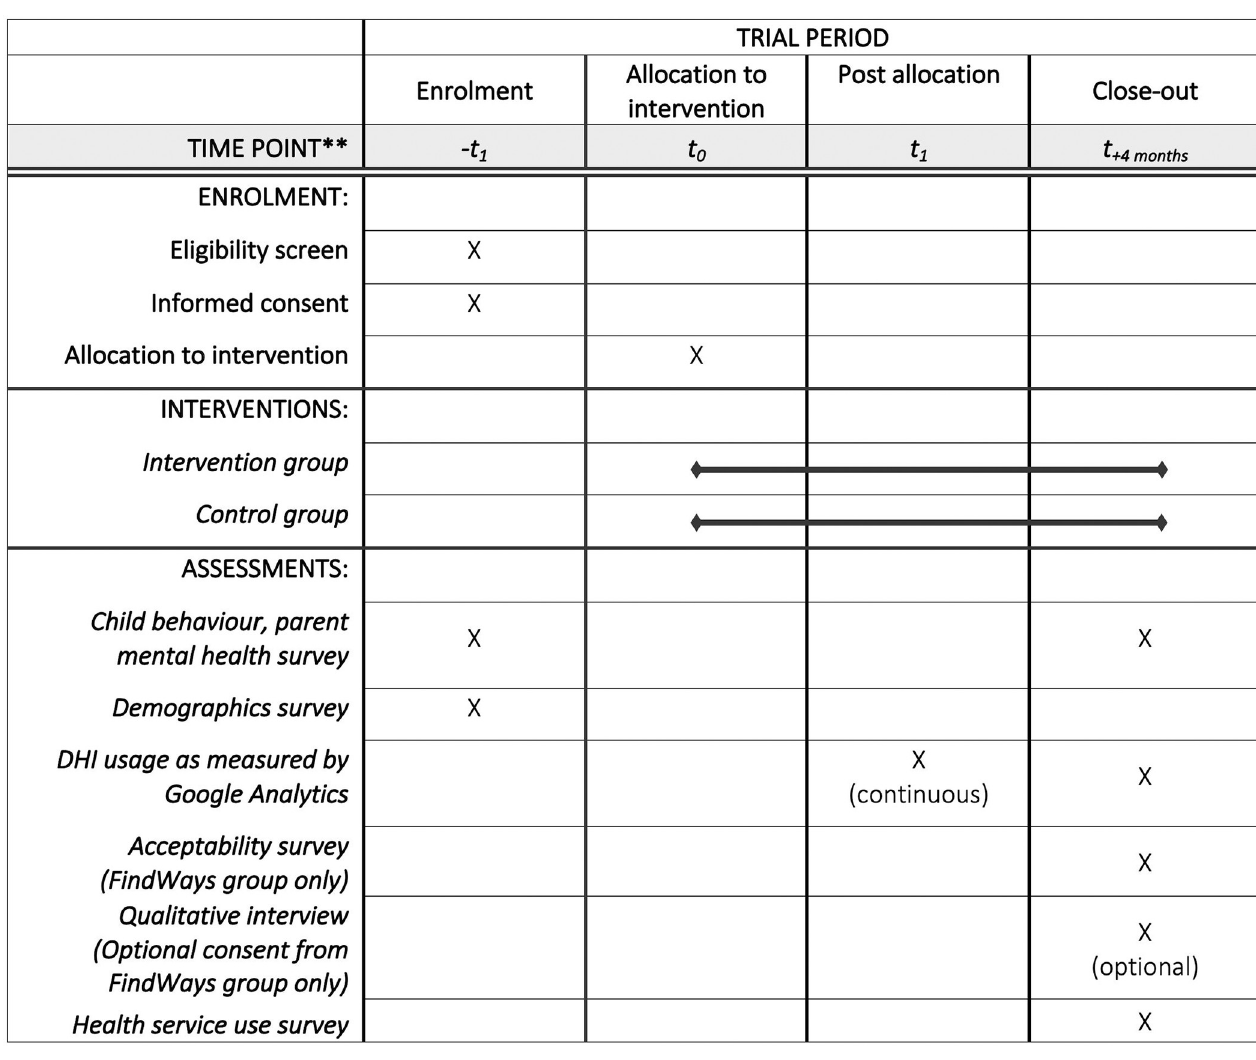
Fig 1. SPIRIT schedule of enrolment, interventions, and